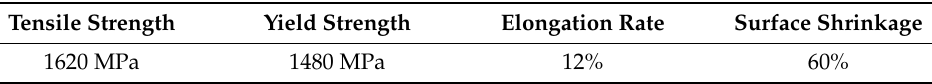
Table 2. Mechanical properties of AF1410